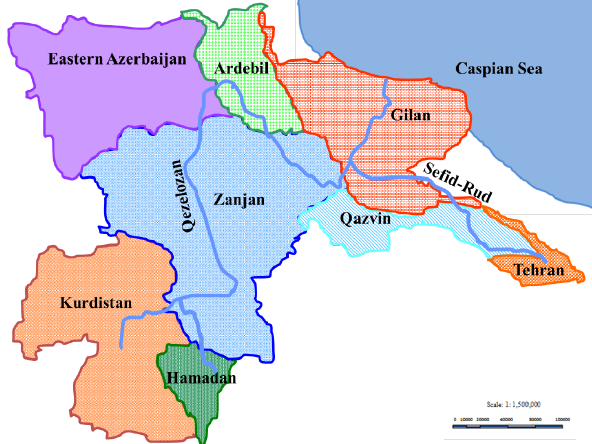
Figure 2. Qezelozan-Sefidrud river system and its eight riparian